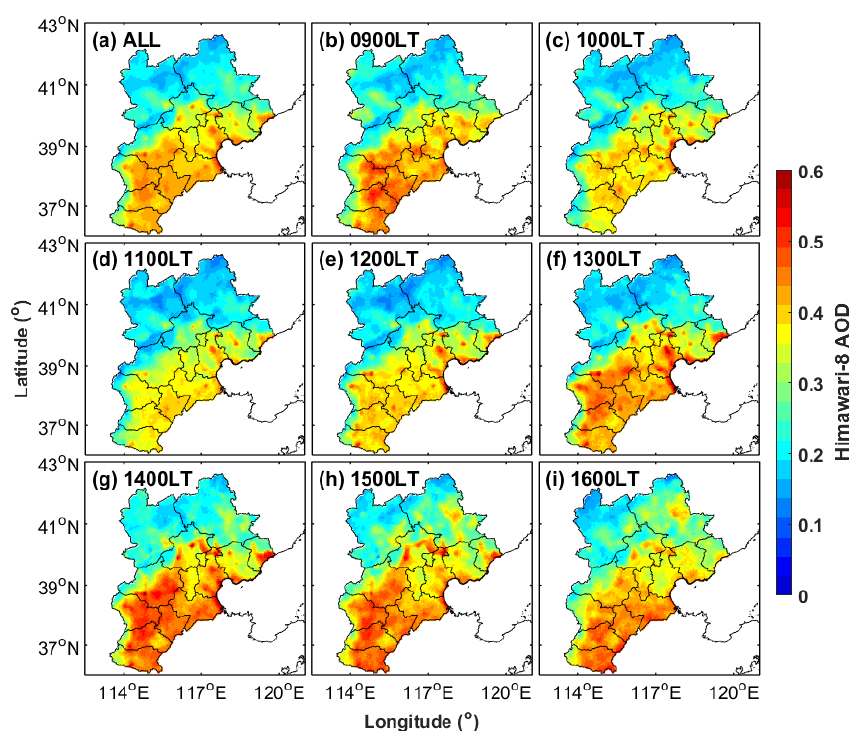
Figure 4. Spatial distributions of the averaged AOD derived from the Himawari-8 for all available data ( a ) and different hours (0900–1600 local time) ( b – i ). The study period is from July 2015 to March 2017.